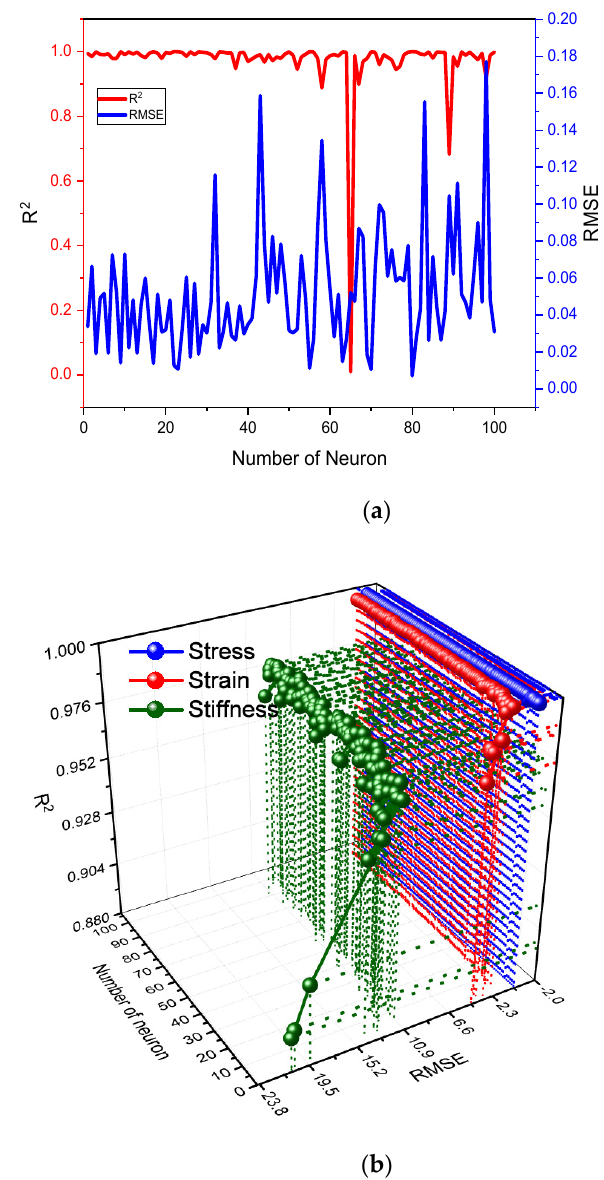
Figure 19. The performance hyperparameters for ANN model ( a ) and ( b ).